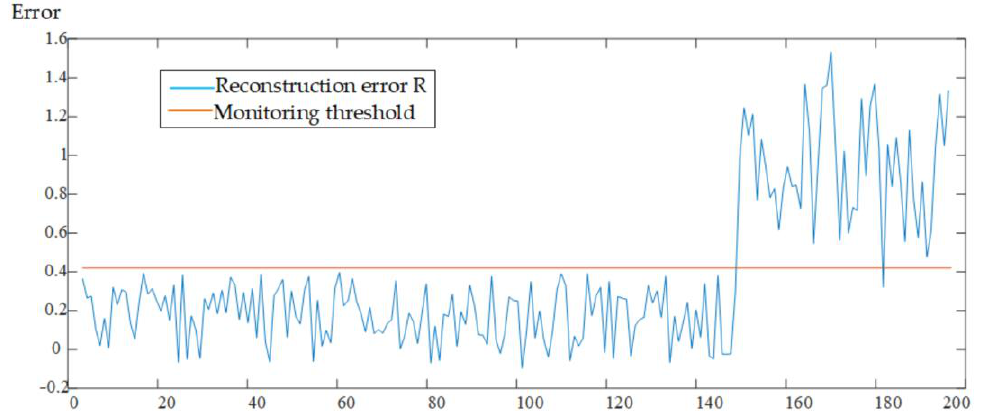
Figure 9. The output of gearbox broken tooth diagnosis model before and after gearbox tooth break of wind turbine B.